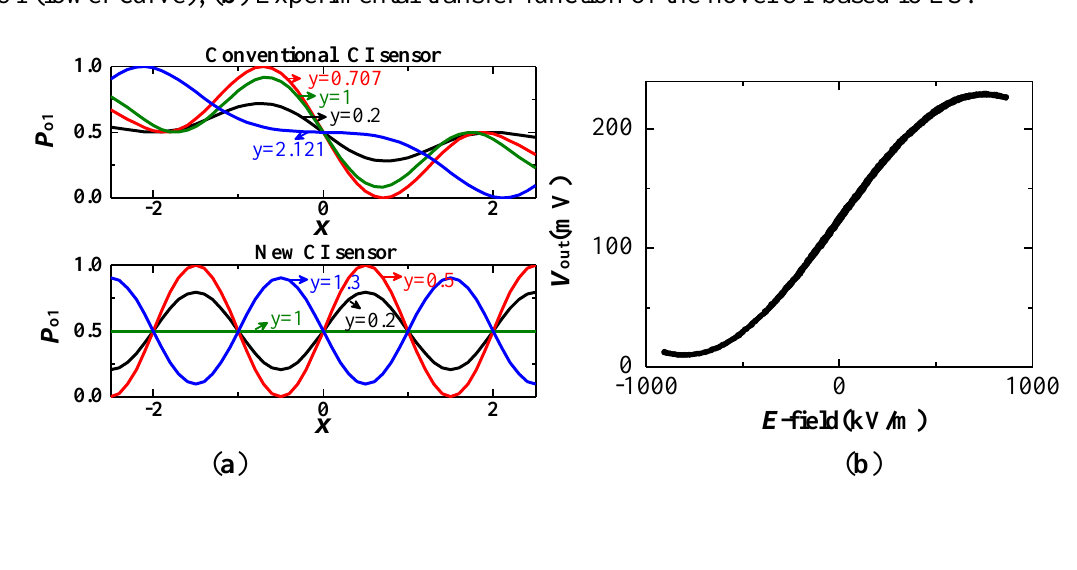
Figure 13. ( a ) Theoretical transfer function of a conventional CI (upper curve) and novel CI (lower curve); ( b ) Experimental transfer function of the novel CI-based